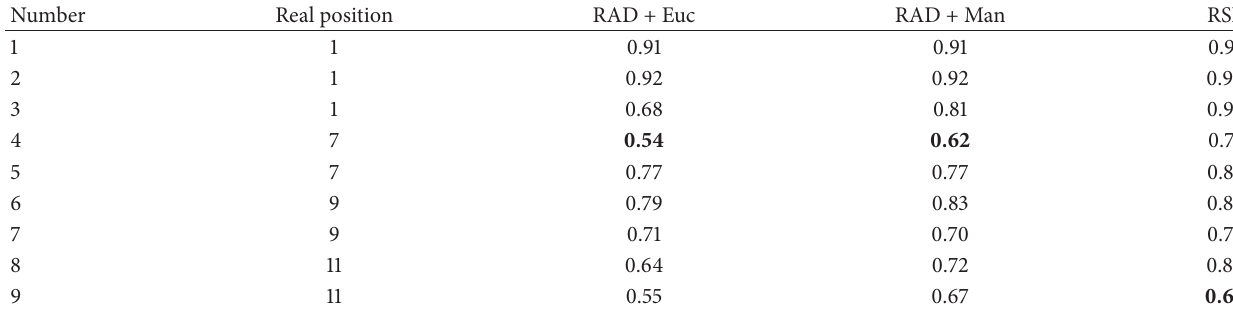
Table 2: PDA comparison for different algorithms.